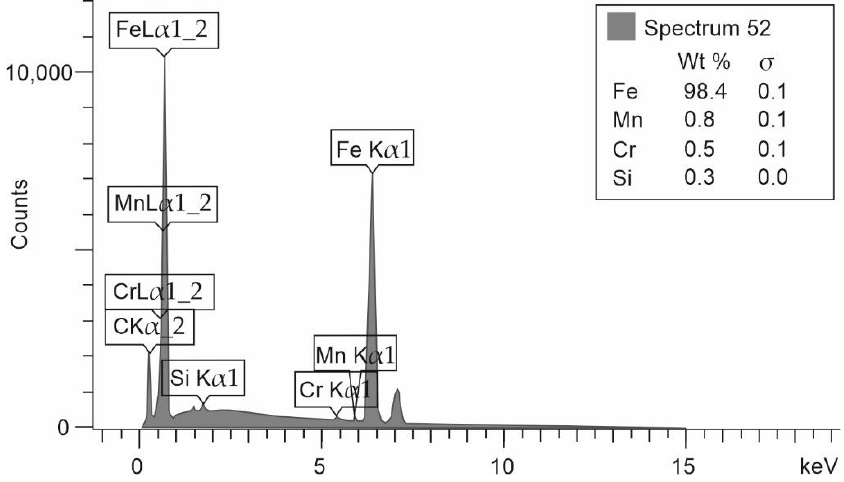
Figure 4. Chemical composition of analyzed slipper-retainer obtained in SEM-EDS analysis.